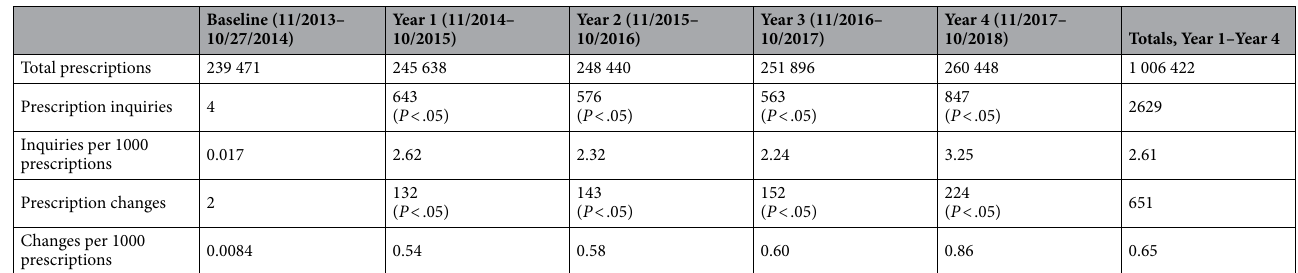
Table 1. Number of prescription inquiries and prescription changes related to laboratory data. During baseline from 11/2013 to 10/27/2014, neither standardized laboratory data nor drug-linking laboratory data was listed on prescription. Year 1, 2, 3 and 4, both type of laboratory data (standardized and drug-linking) were listed on prescription. A statistically significant difference was observed between baseline and each year ( P < .05, Fisher’s exact